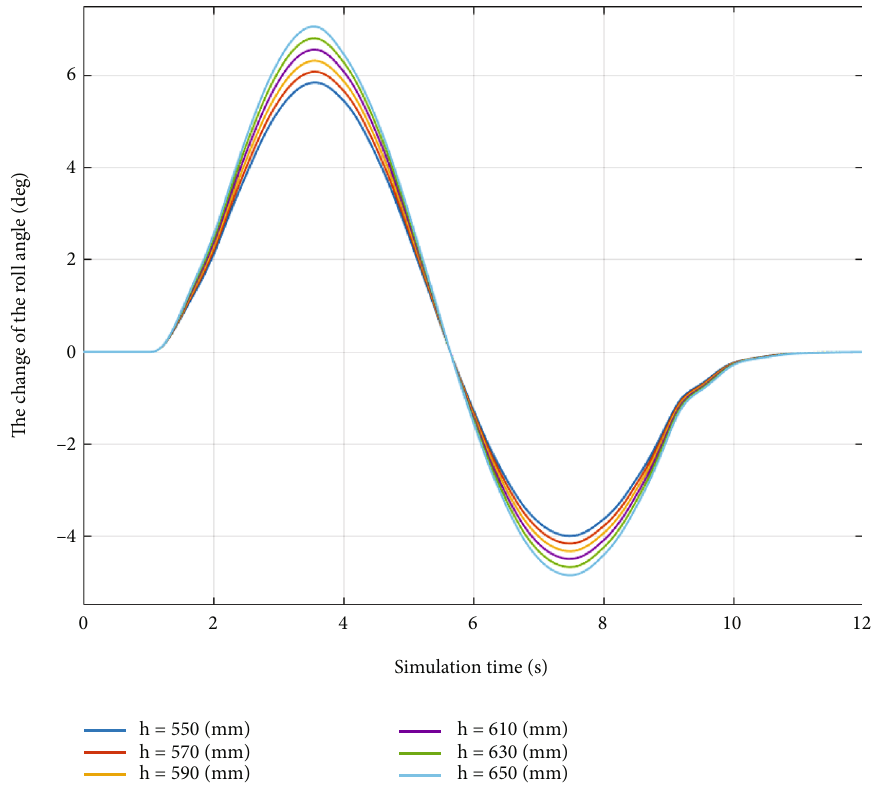
Figure 14: The change of the roll angle (the third case — distance change).